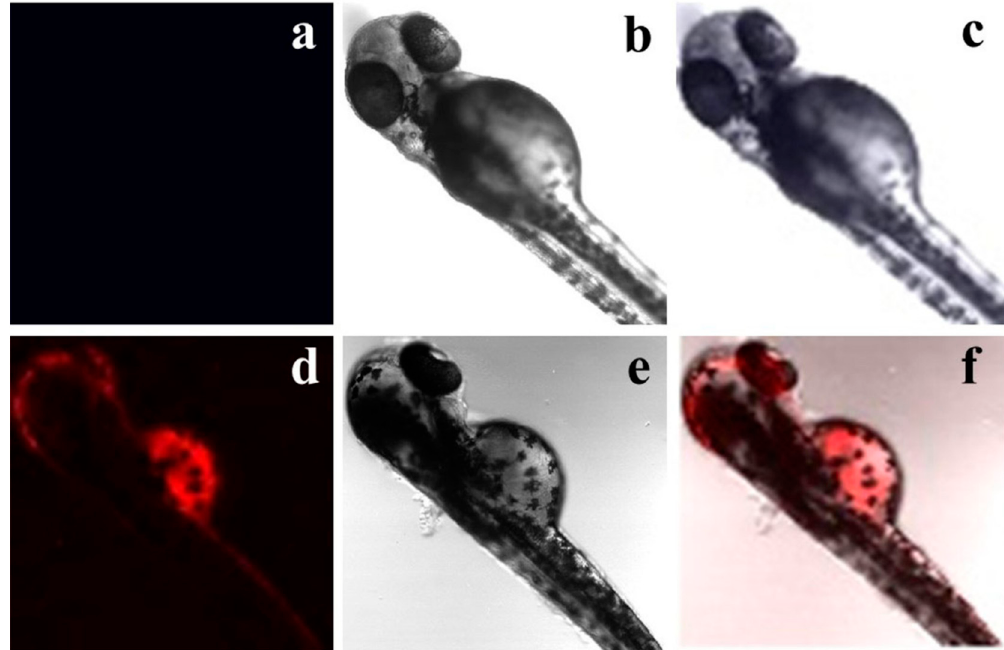
Figure 2. Fluorescence images of Fe 3+ in zebrafish using the probe 30 ( λ exc = 546 nm, fluorescent signals were collected at 550–650 nm). ( a ) Fluorescent image, ( b ) bright field image, and ( c ) merged image of zebrafish incubated with the probe 30 (10 mM) for 20 min. ( d ) Fluorescent image, ( e ) bright field image, and ( f ) merged image of probe 30 -loaded zebrafish incubated with Fe 3+ (40 μ M) for 20 min (Reproduced from Ref. [38] with permission from Elsevier).